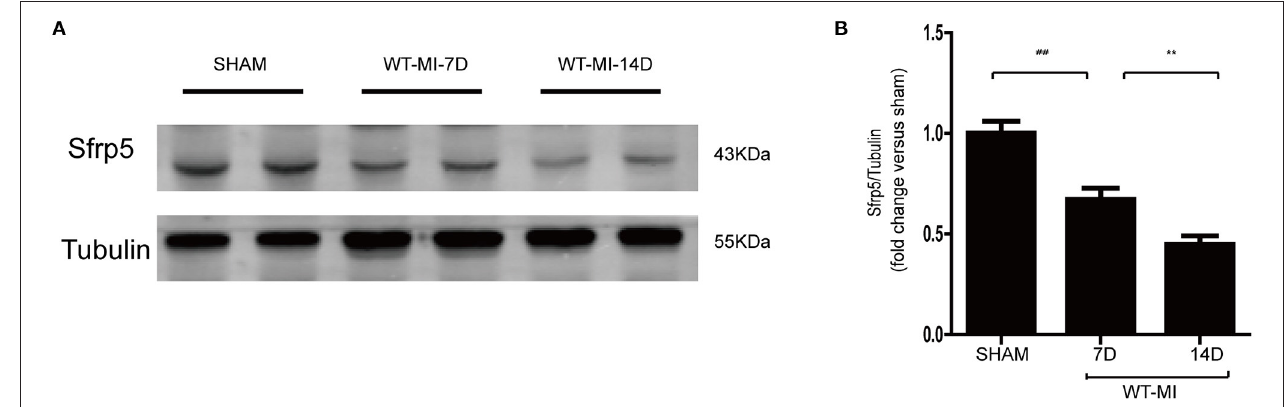
FIGURE 1 | Expression levels of Sfrp5 in hearts after MI. (A) Protein expression of Sfrp5 in mouse hearts at 7 and 14 days after MI. (B) Quantitative analysis of the relative Sfrp5 protein expression. Tubulin was used as a loading control (values are presented as mean ± SD, n = 6 per group). ## p < 0.01 mice at 7 days after MI vs. mice at 7 days after sham operation. ** p < 0.01 mice at 14 days after MI vs. mice at 7 days after